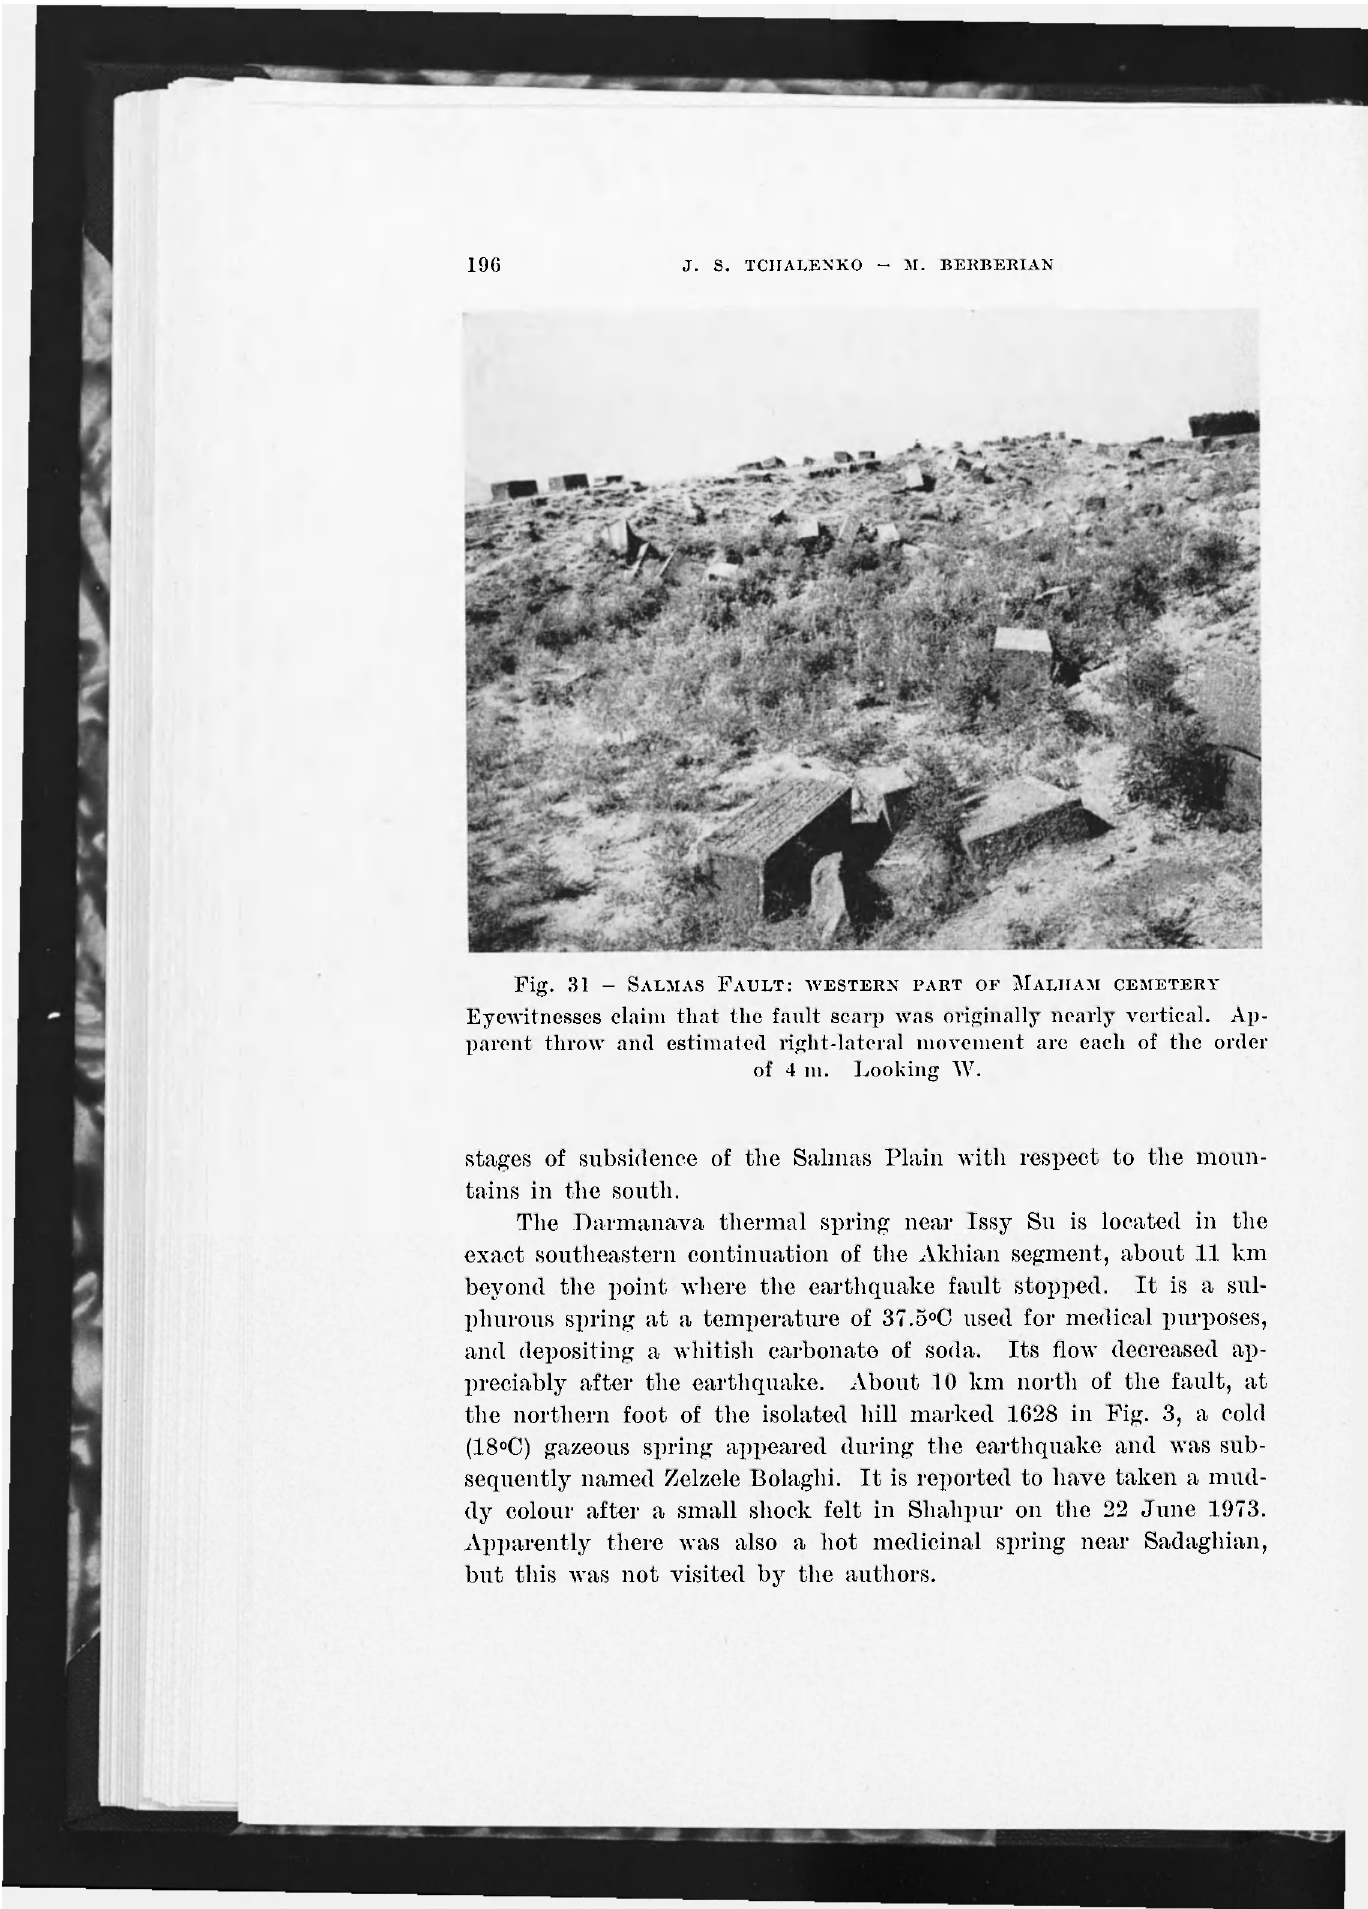
Fig. 31 - SALMAS FAULT: WESTERN PART OF MALHAM CEMETERY Eyewitnesses claim that the fault scarp was originally nearly vertical. Ap- parent throw and estimated right-lateral movement are each of the order of 4 m. Looking